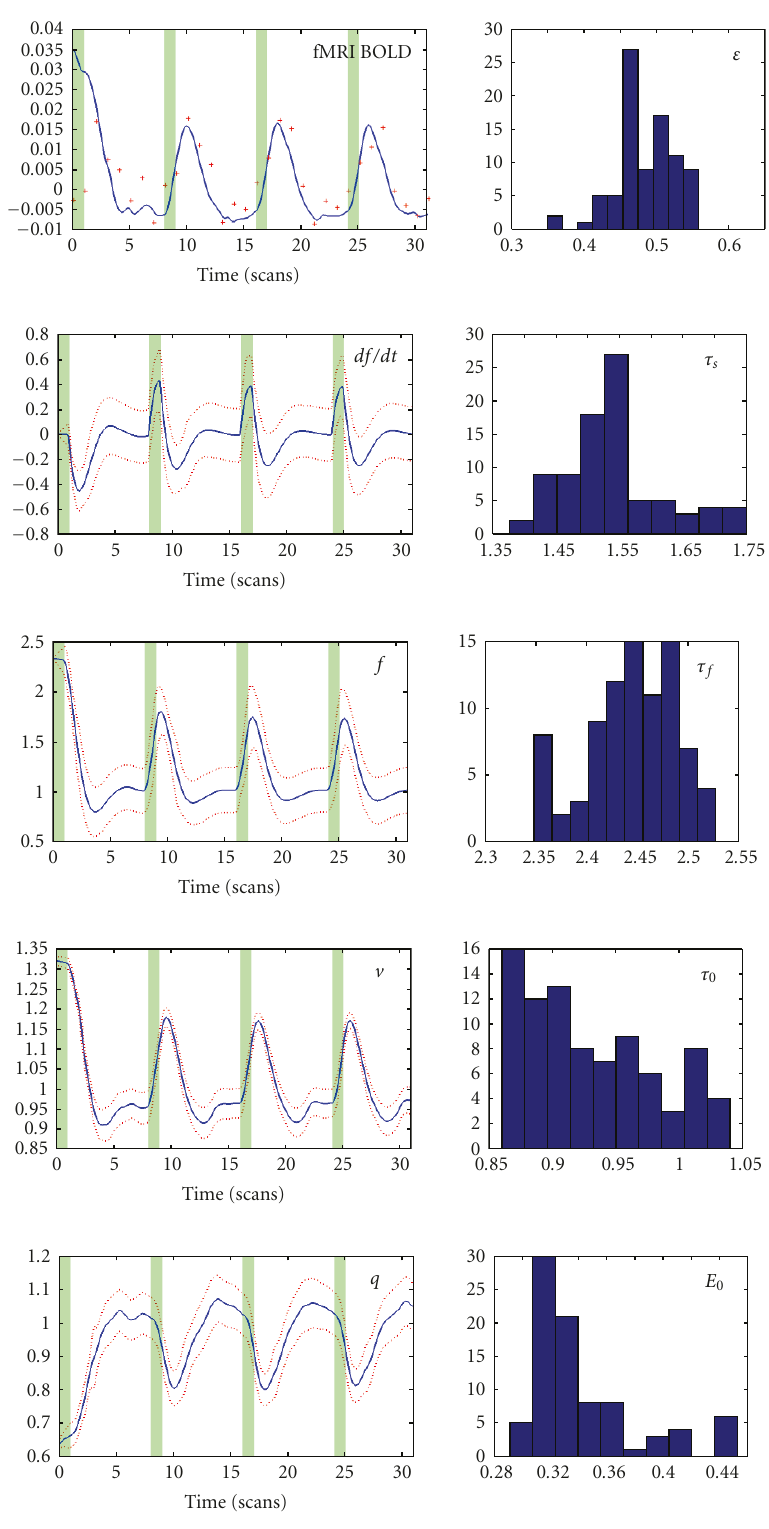
Figure 9: The left column shows time series of the estimated states functions of hemodynamic response to touch perception tasks. From top to bottom: BOLD signal y (the measured signal (red plus sign) and the filtering process (blue line)), ˙ f , f , v , and q . Note that our inversion scheme allows for random fluctuations on the parameters. This means that we have distribution as opposed to a point estimate for these quantities. These distributions are shown in the right column. From top to bottom: (cid:2) , τ s , τ f , τ 0 , E 0 . Each stimulus event, which was simulated by rectangular pulse of width 2-seconds, is shown as strips in green. These red bounds are given by its standard deviation σ